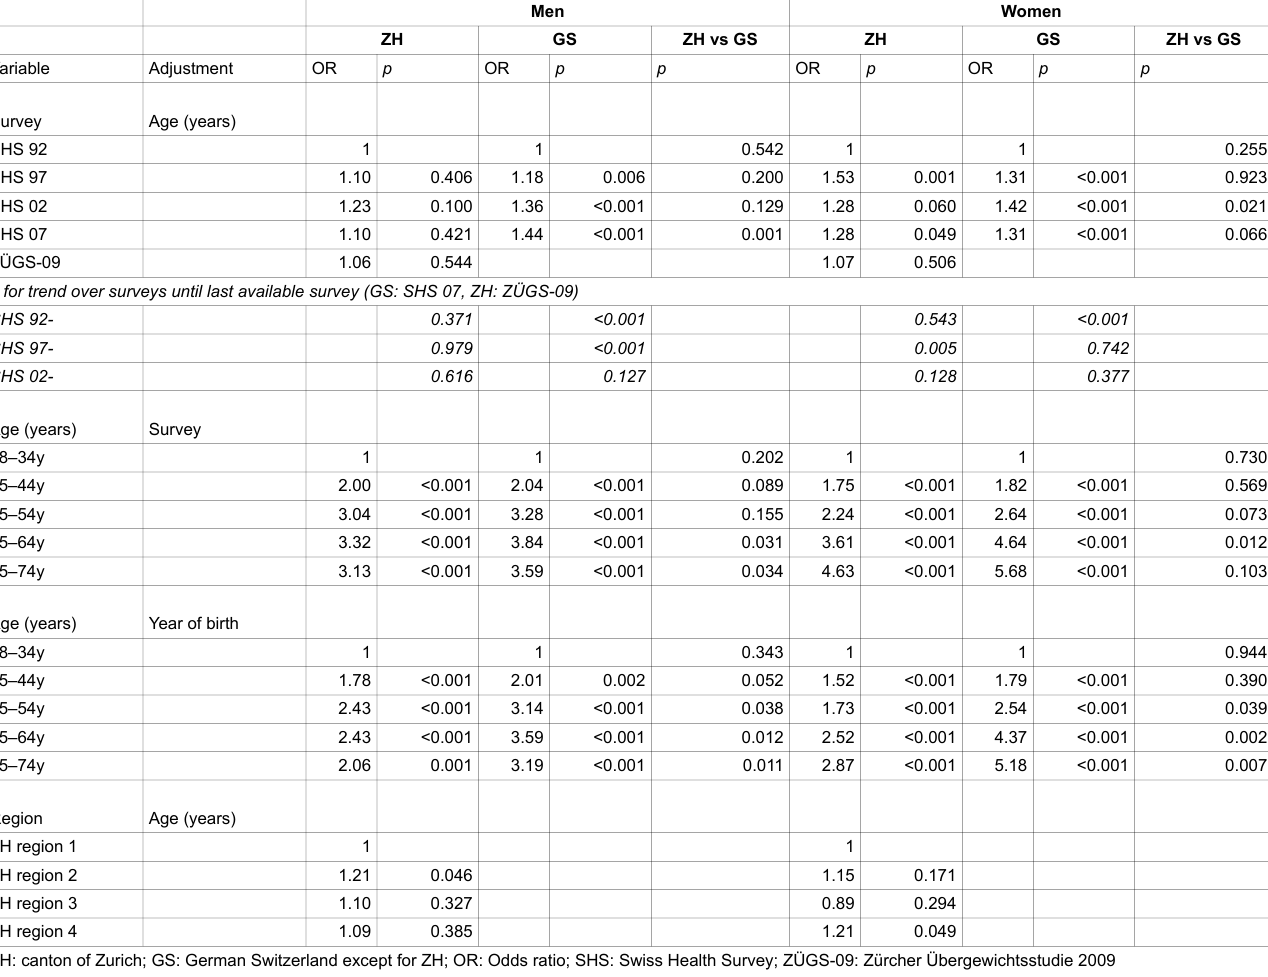
Table 2 Population weighted odds ratios for excess weight (vs. normal weight) in the canton of Zurich and the rest of German Switzerland, by sex, 1992–2009, men and women aged 18–74 years (n =